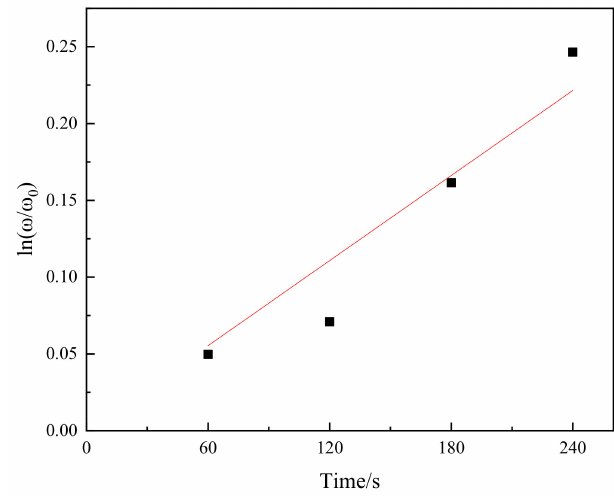
Figure 6. Relationship between ln ( ω / ω 0 ) and reaction time.